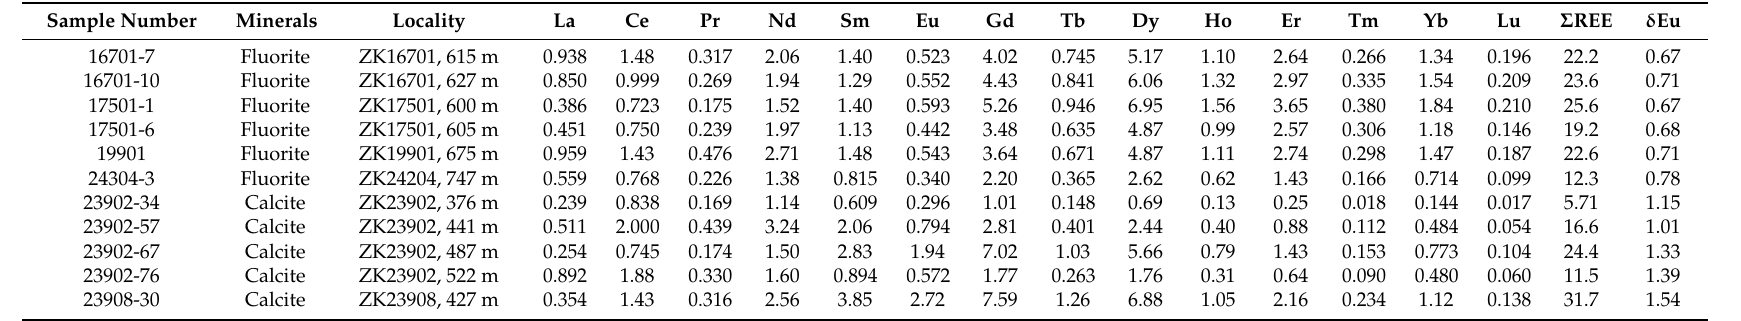
Table 1. REE data ( µ g / g) for fluorite and calcite from the Shuiyindong